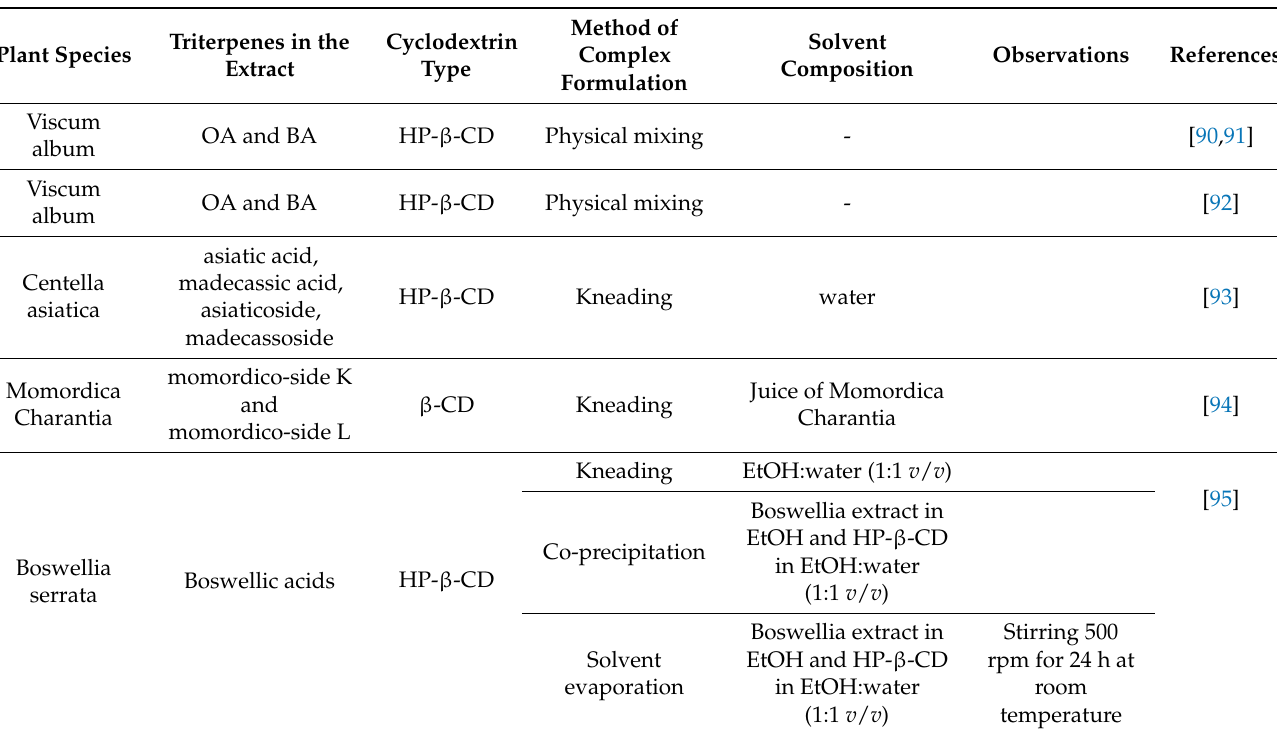
Table 4. Methods of preparation of cyclodextrin inclusion complexes with plant extracts containing triterpenic